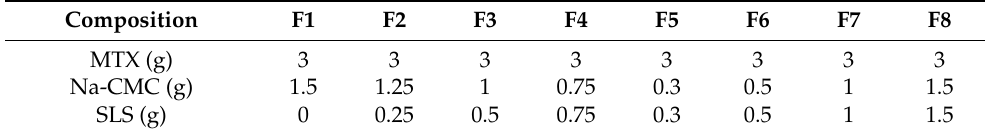
Table 1. Compositions of the surface-attached solid dispersions with different carrier ratios. Composition F1